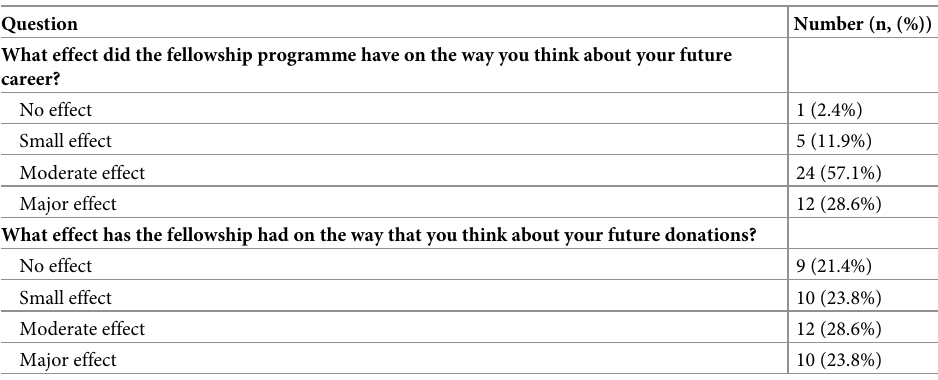
Table 7. Impact of fellowship on how participants perceive their careers.